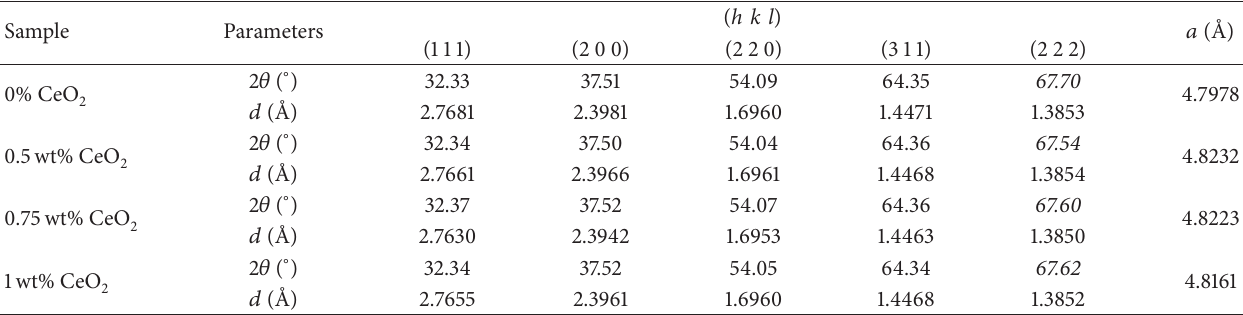
Table 1: Calculated lattice constant for sintered